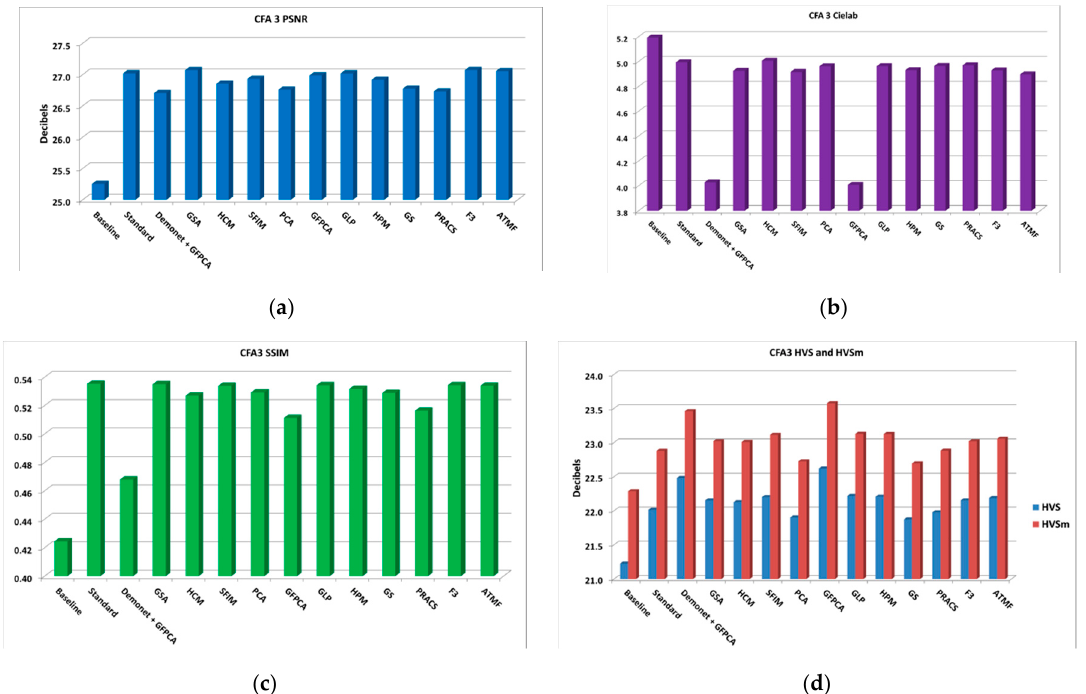
Figure 18. Averaged performance metrics for all the low light images at 20 dBs SNR (Poisson noise).